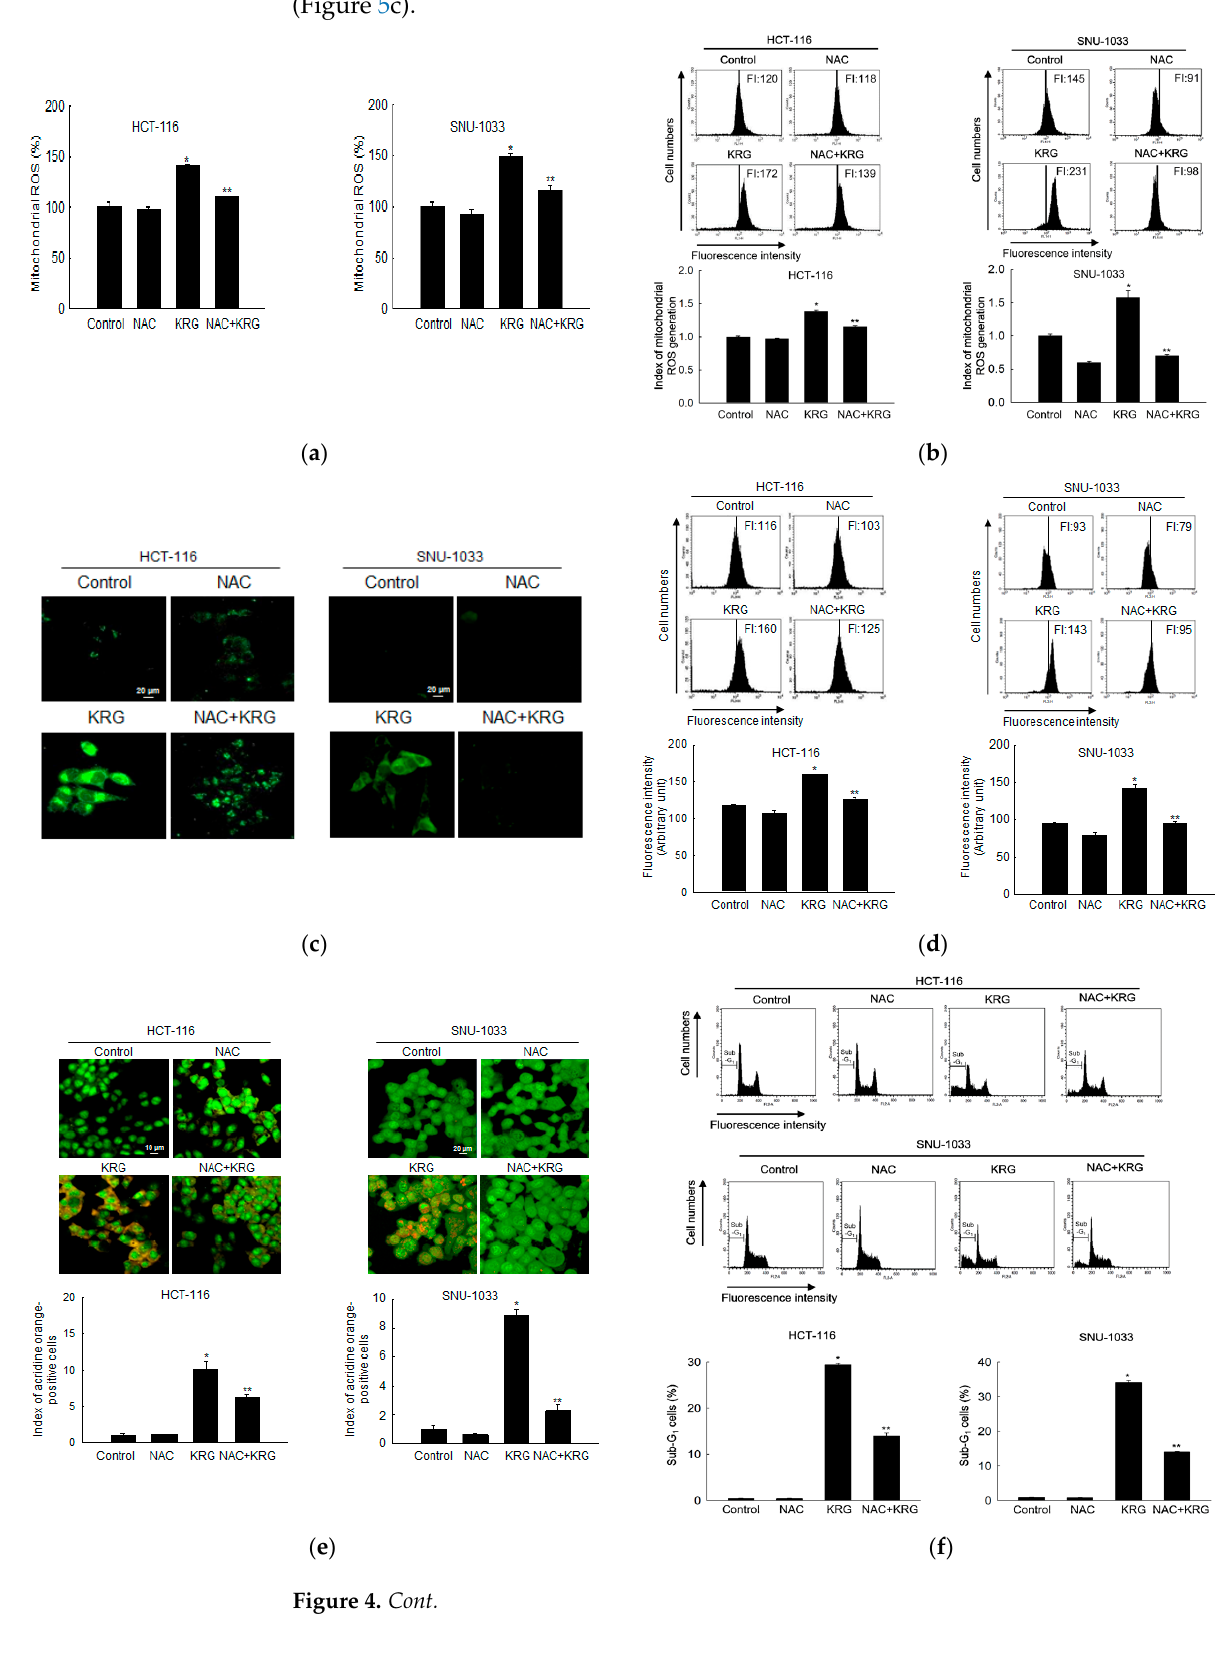
Figure 4. KRG extract induces autophagy-mediated cell death via generation of mitochondrial ROS. Cells were incubated with the KRG extract (2 mg/mL in HCT-116; 2.3 mg/mL in SNU-1033) in the presence or absence of NAC (1 mM) for 48 h. Mitochondrial ROS levels were assessed using ( a ) spectrofluorometry, ( b ) flow cytometry, and ( c ) fluorescence microscopy after DHR 123 staining. Scale bar, 20 μ m. * p < 0.05 vs. untreated control; ** p < 0.05 vs. the KRG extract-treated cells. The KRG extract-induced autophagy was assessed using ( d ) flow cytometry and ( e ) fluorescence mi- croscopy after acridine orange staining. Scale bar, 10 μ m (HCT-116) and 20 μ m (SNU-1033). * p < 0.05 vs. untreated control; ** p < 0.05 vs. the KRG extract-treated cells. ( f ) Apoptotic sub-G 1 DNA content was detected and quantified using flow cytometry after PI staining. * p < 0.05 vs. untreated control ; ** p < 0.05 vs. the KRG extract-treated cells. ( g ) Cells were incubated with the KRG extract (2.0 mg/mL in HCT-116; 2.3 mg/mL in SNU-1033) in the presence or absence of NAC (1 mM) for 48 h, and cell viability was assessed using the MTT assay. * p < 0.05 vs. control; ** p < 0.05 vs. the KRG extract-treated cells. 3.5. Ginsenoside Rg2 of KRG is the Most Effective Component Responsible for KRG-Induced Autophagy-Mediated Cell Death or Apoptosis of Colon Cancer Cells We evaluated ginsenosides Rb1, Rc, Rg2, and Rg3, which are the top four most abundant ginsenosides in the KRG extract, for their effects on autophagy-mediated cell death or apop- tosis of colon cancer cells. As shown in Figure 5a, ginsenosides suppressed the proliferation of HCT-116 and SNU-1033 cells in a concentration-dependent manner, and Rg2 was found to be the most effective in both the cell lines. The fluorescence intensity of acridine orange in gin- senoside Rg2-treated cells was higher than that in other ginsenoside-treated cells (Figure 5b). In addition, ginsenoside Rg2 was the most effective inducer of apoptosis among the ginseno- sides, as indicated by the formation of apoptotic bodies (Figure 5c).